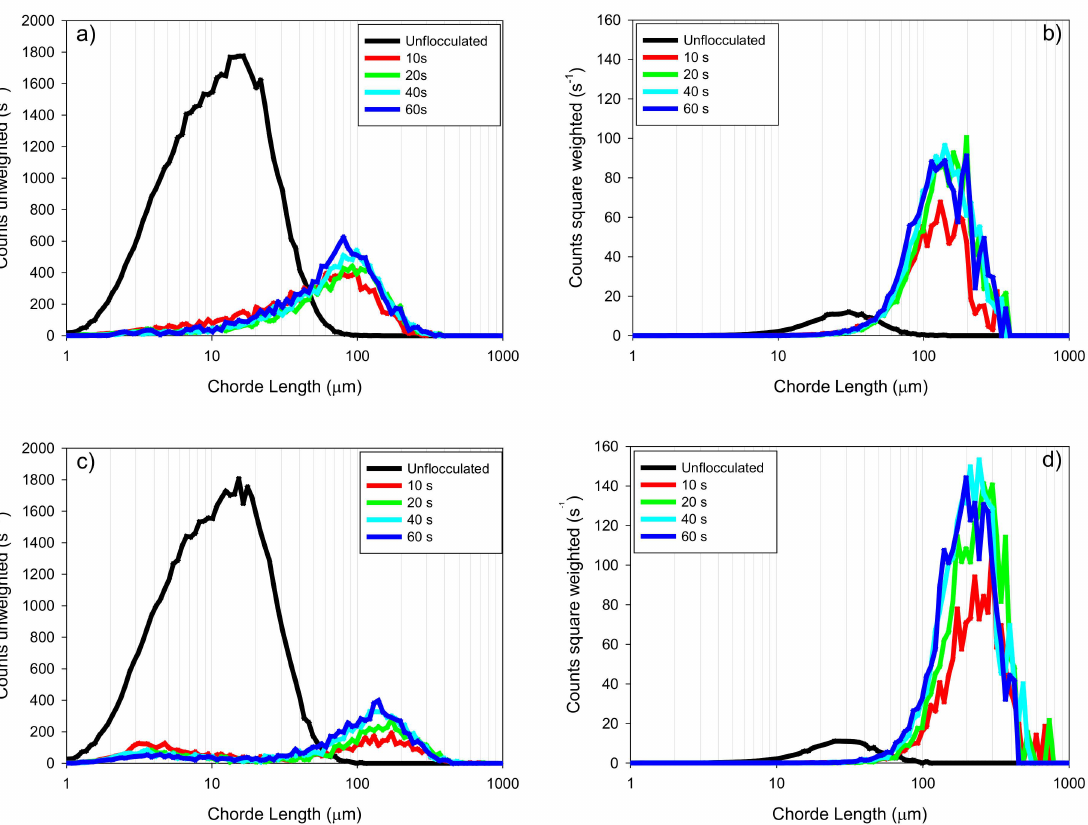
Figure 7. ( a ) unweighted chord length distribution (CLD) for KQ in SW, ( b ) square-weighted CLD for KQ in SW, ( c ) unweighted CLD for KQ in IW, ( d ) square-weighted CLD for KQ in IW. Flocculant dose 34 g/t, mixing rate 180 rpm, solids concentration 8 wt% (clay/quartz 10/90), pH 8. KQ = kaolin/quartz, SW = seawater, IW = industrial